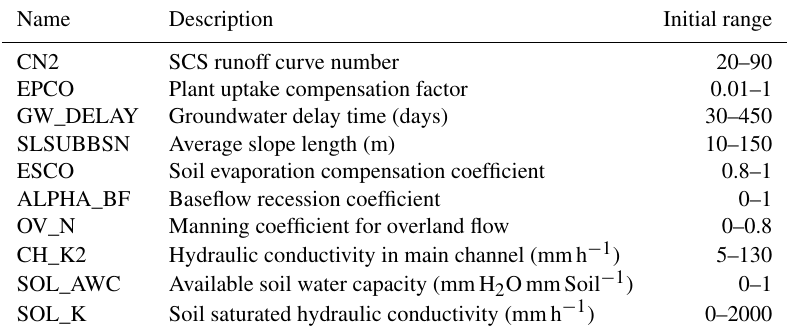
Figure 6. Model performance for the calibrations using short-period data in Jinjiang Basin. Table 4. SWAT model parameters being